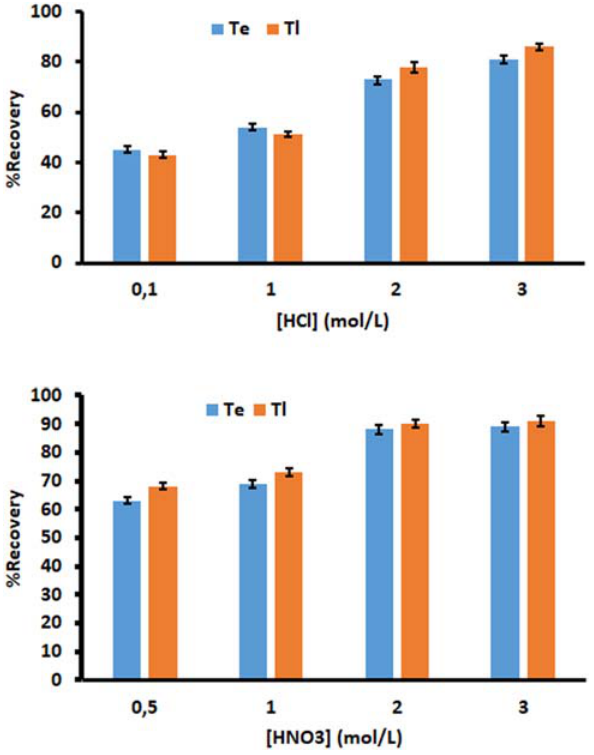
Figure 4: SEM ( left ) , TEM ( right ) and XRD pattern of MPC@Fe 3 O 4 @SiO 2 .